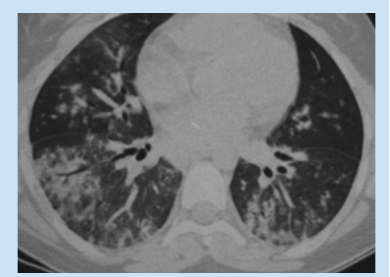
Fig. 6. Patchy airspace opacification.